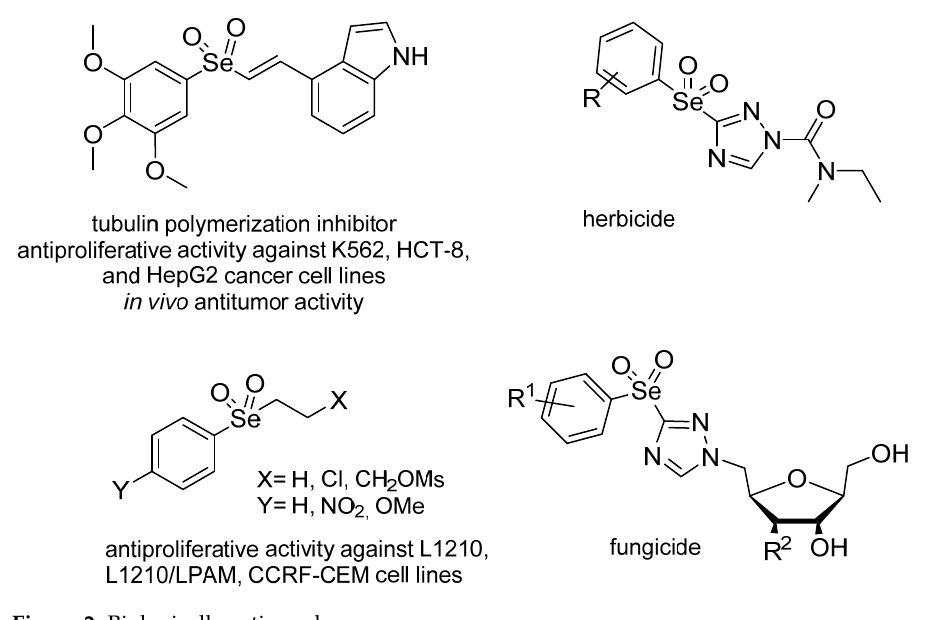
Figure 2. Biologically active selenones.